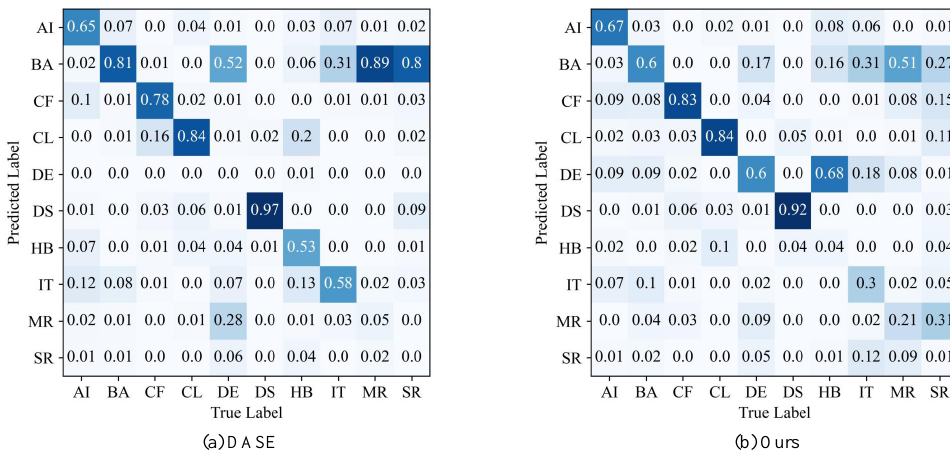
Figure 6. Confusion matrix of the two methods on the NWPU45 dataset. Where “AI”, “BA”, “CF”, “CL”, “DE”, “DS”, “HB”, “IT”, “MR”, and “SR” denotes “airport”, “basketball court”, “circular farmland”, “cloud”, “dense residential”, “desert”,“harbor”, “intersection”, “medium residential” and “sparse residential”, respectively.